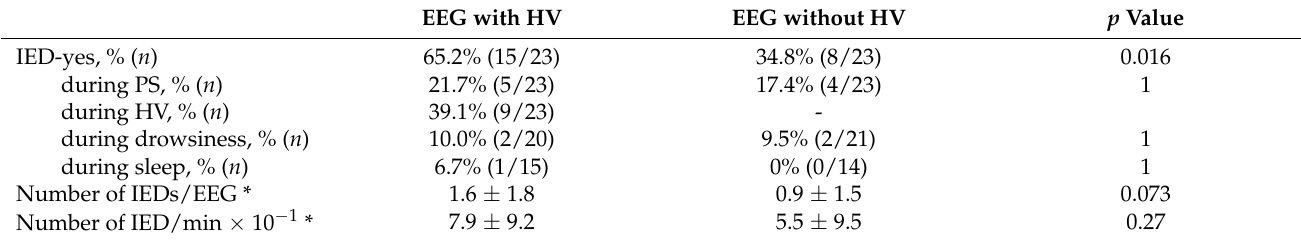
Table 2. Outcome measures comparing EEGs with HV and without HV.